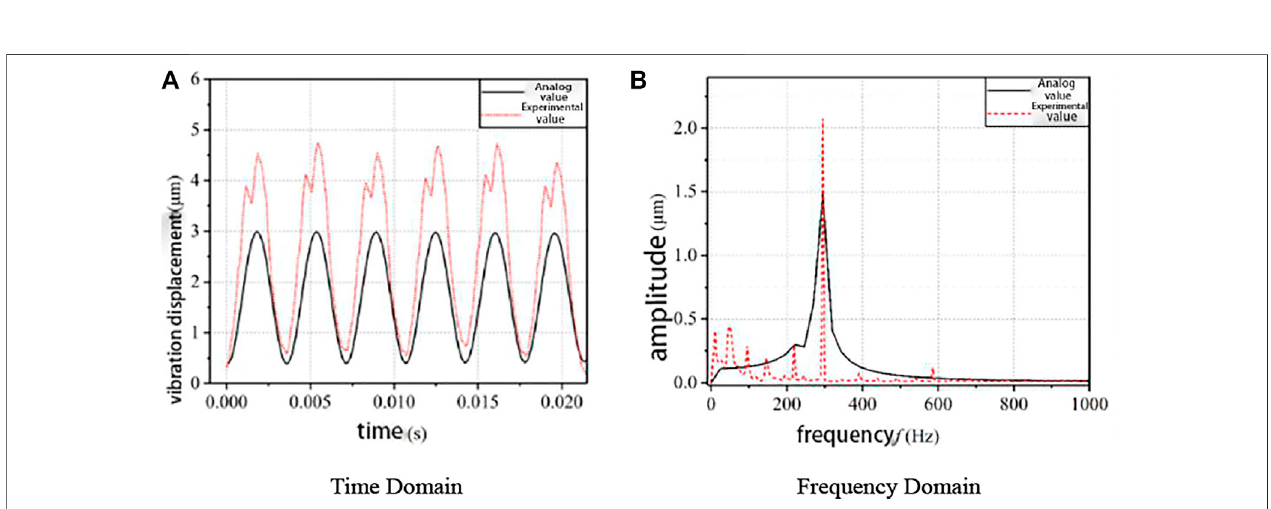
Frontiers in Energy Research |